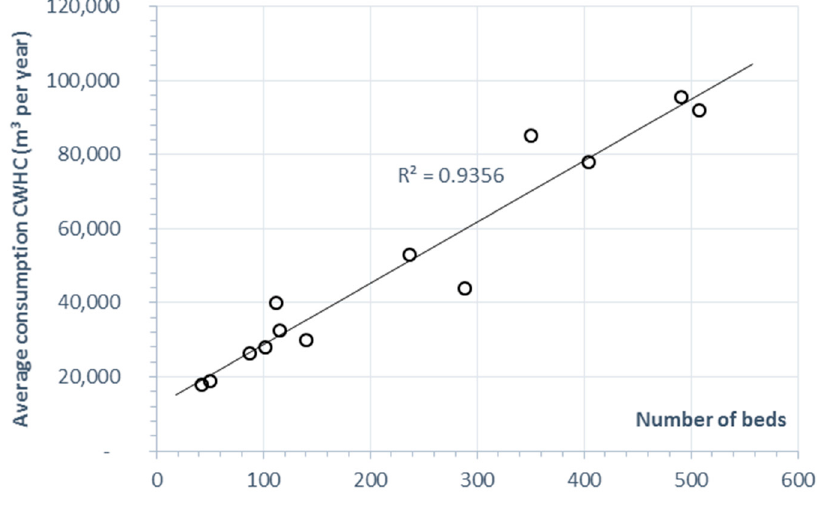
Figure 5. Relationship between the average annual cold water for human consumption and the number of beds in a hospital.